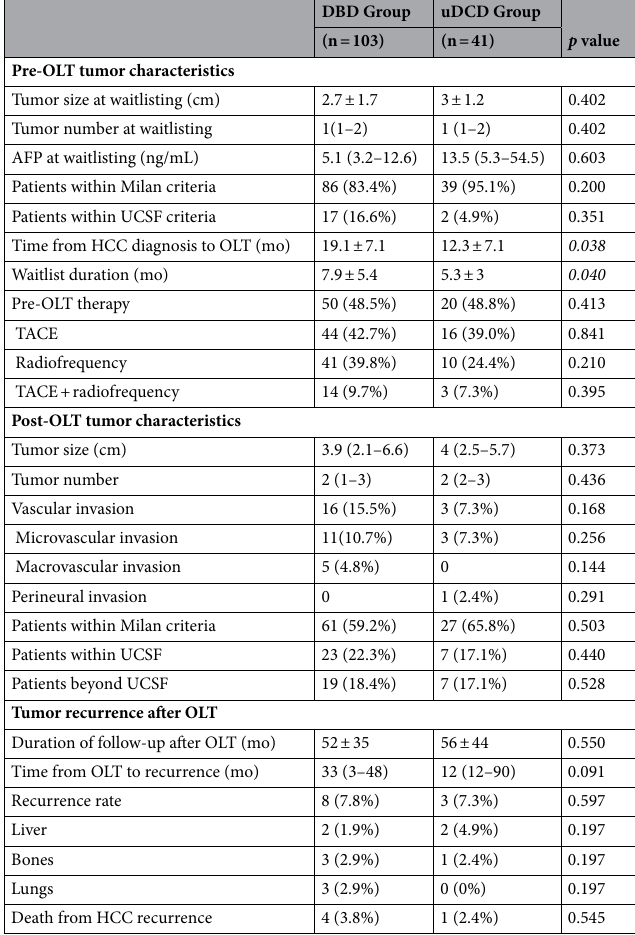
Table 3. Preoperative and postoperative tumor characteristics, and post-orthotopic liver transplantation recurrence. Italic values indicate statistically significant. AFP alpha-fetoprotein; DBD donation after brain death; HCC hepatocellular carcinoma; OLT orthotopic liver transplantation; TACE transarterial chemoembolization; UCSF University of California, San Francisco; uDCD uncontrolled donation after circulatory death.